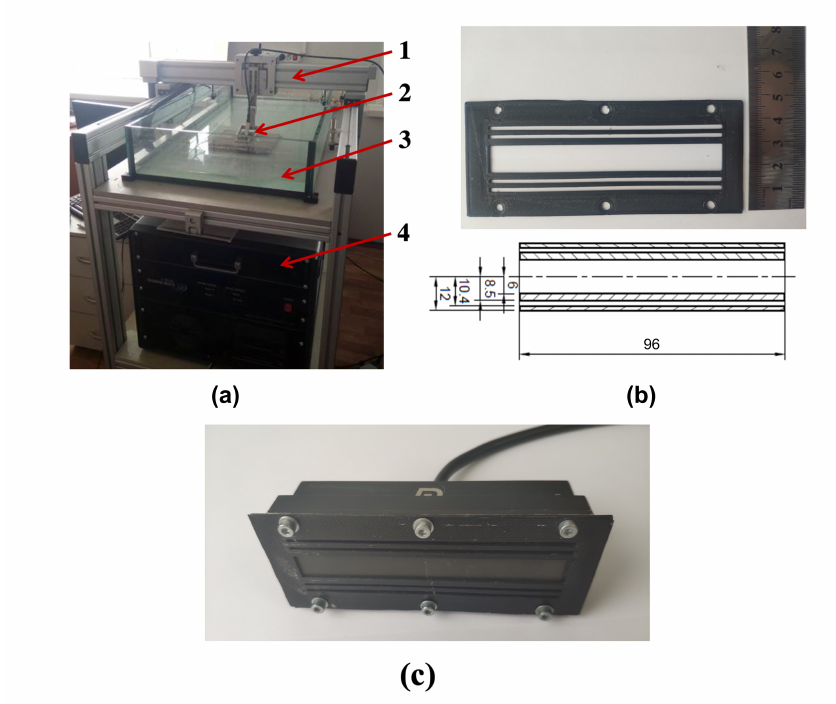
Figure 5. Photo of ( a ) Idealsystem3D experimental set-up, where 1 is the ultrasonic scanner, 2 PA, 3 immersion bath and 4 electronic unit. Photo and scheme of ( b ) manufactured PR-FZP. Photo of the lens ( c ) mounted in the PA.